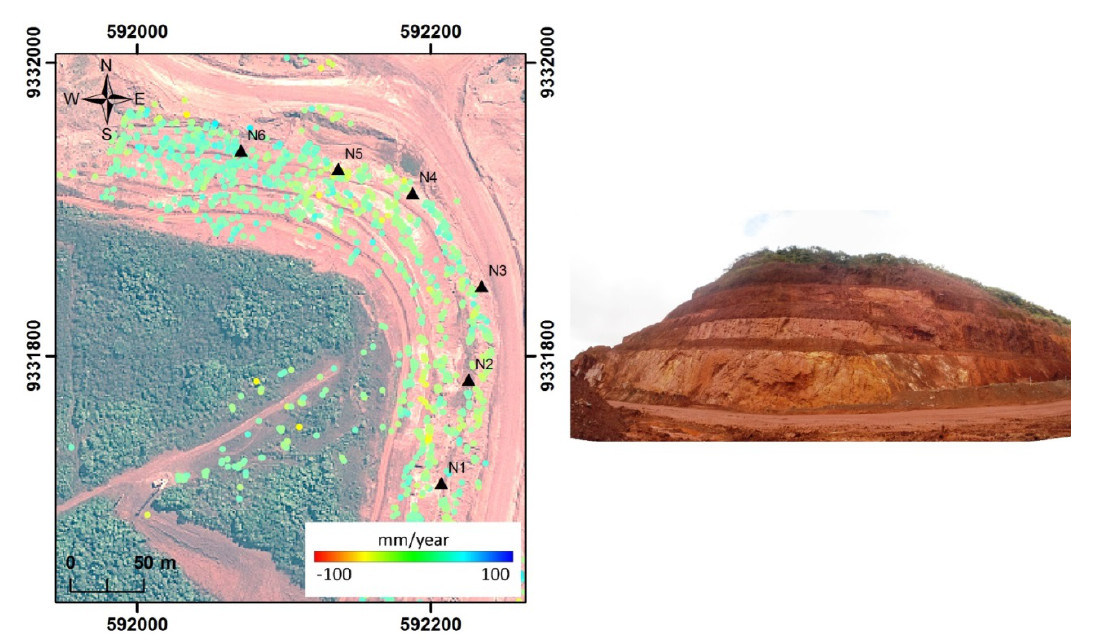
Figure 7. The left-side picture corresponds to the optical leveling and PS locations. The background image is a GeoEye-1 colored composition. The right-side picture is a general view of the monitored slopes. The picture was taken on 15 March